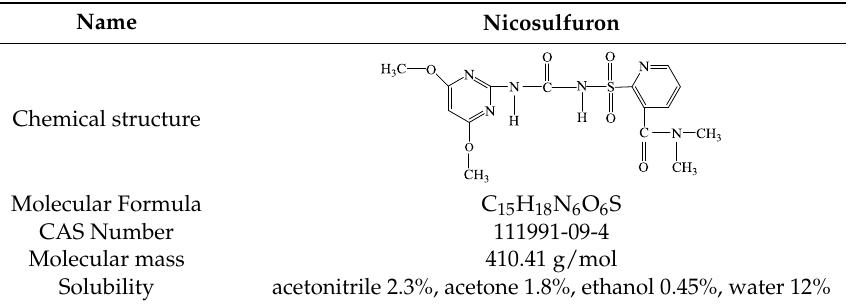
Table 1. General characteristics of nicosulfuron.